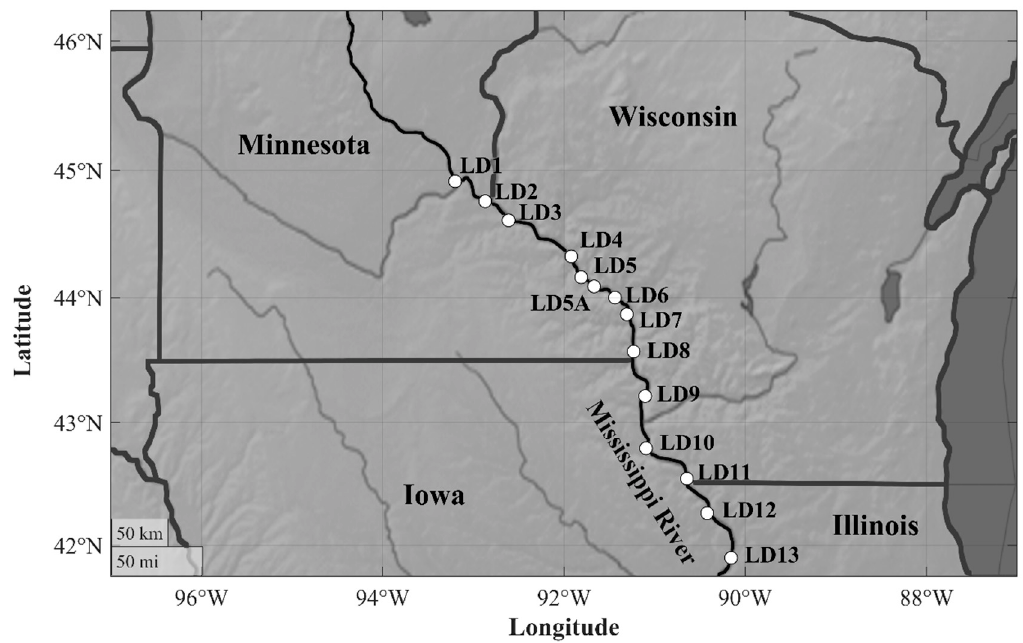
Figure 1. Location of locks-and-dams (LDs) in the upper portion of the Upper Mississippi River (UMR). See Table 1 for details on LDs.